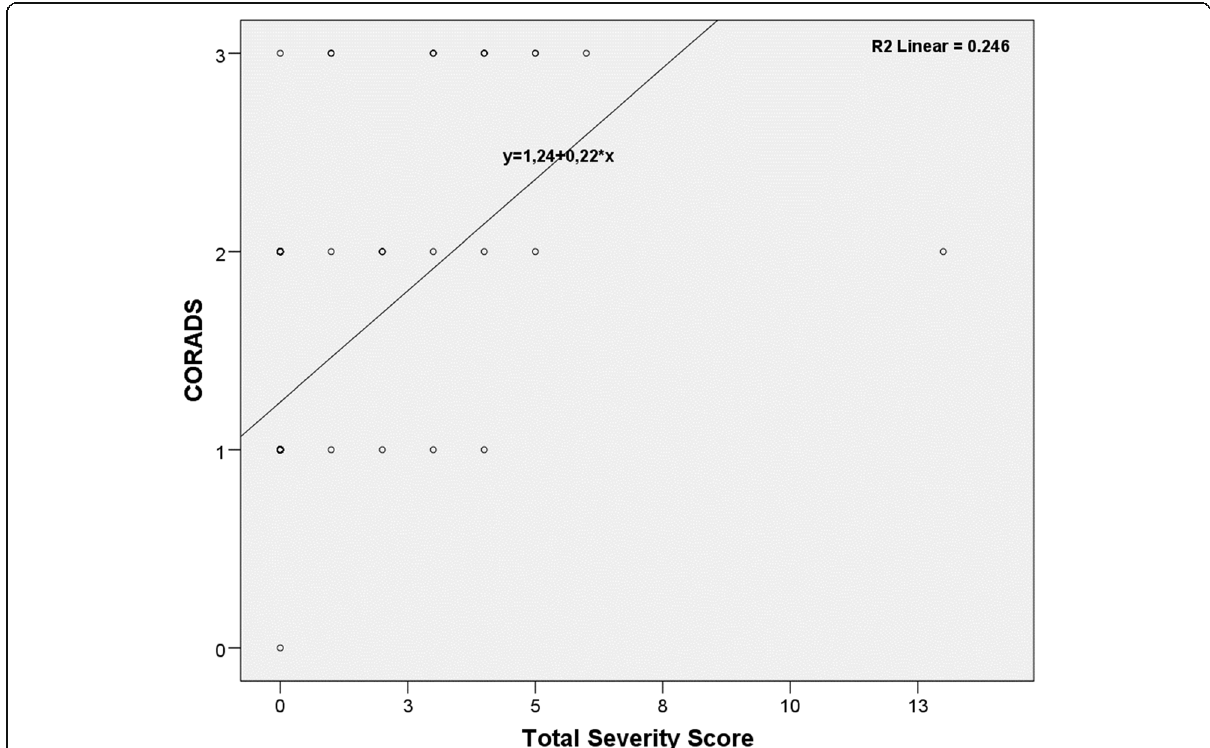
Fig. 5 Correlation scatter graph between CO-RADS scale and Total Severity